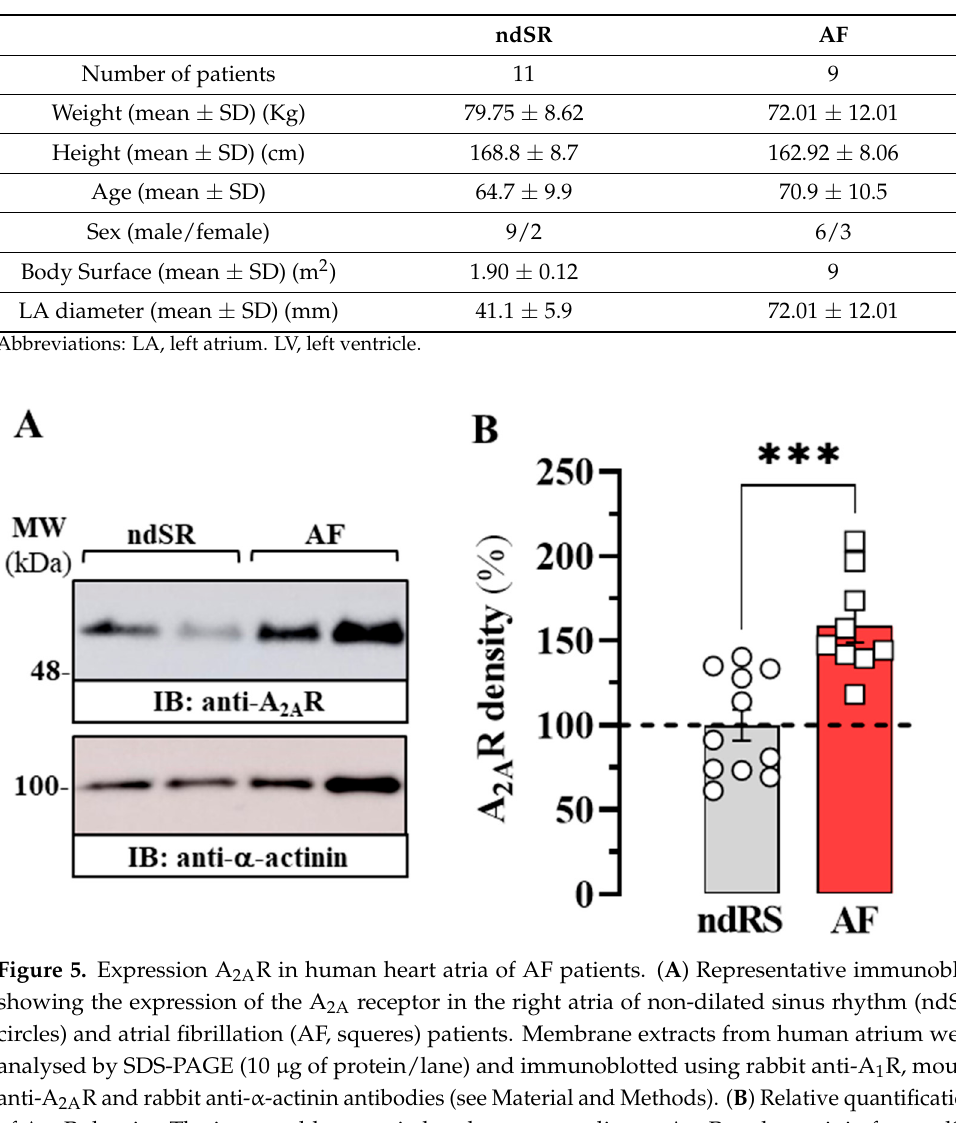
Table 1. Baseline demographic characteristics of AF patients.